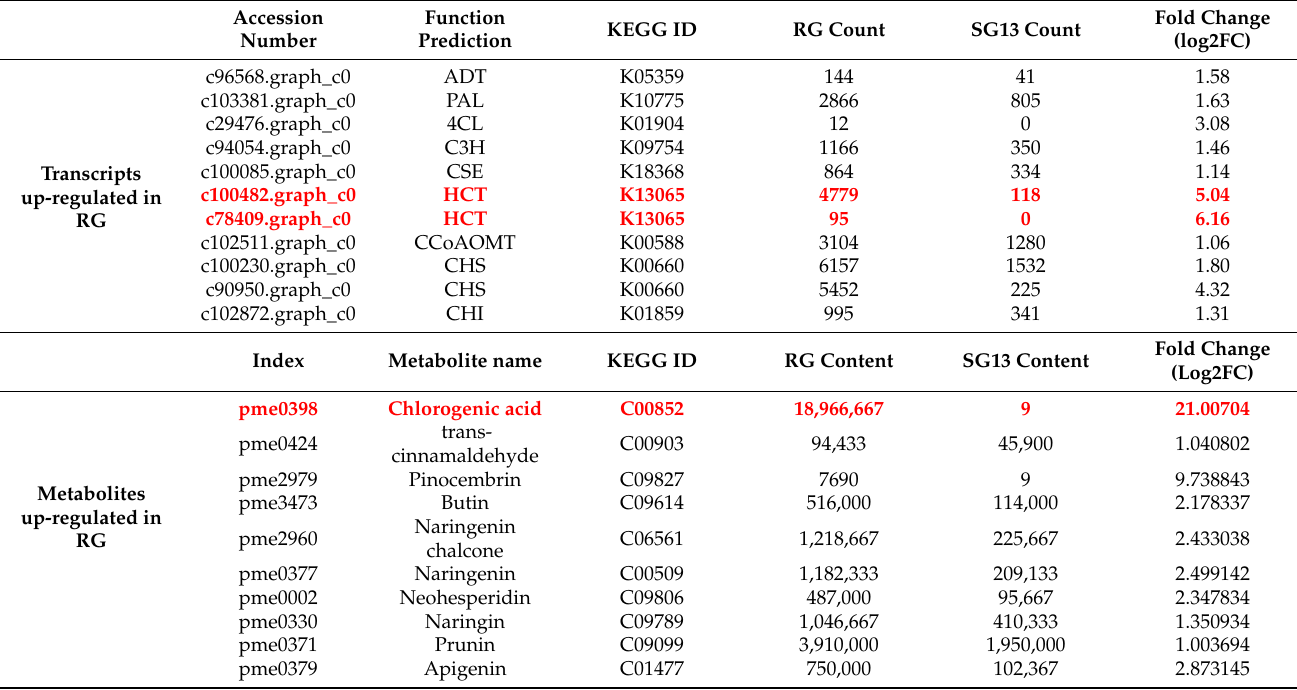
Table 2. List of transcripts and metabolites up-regulated in RG.